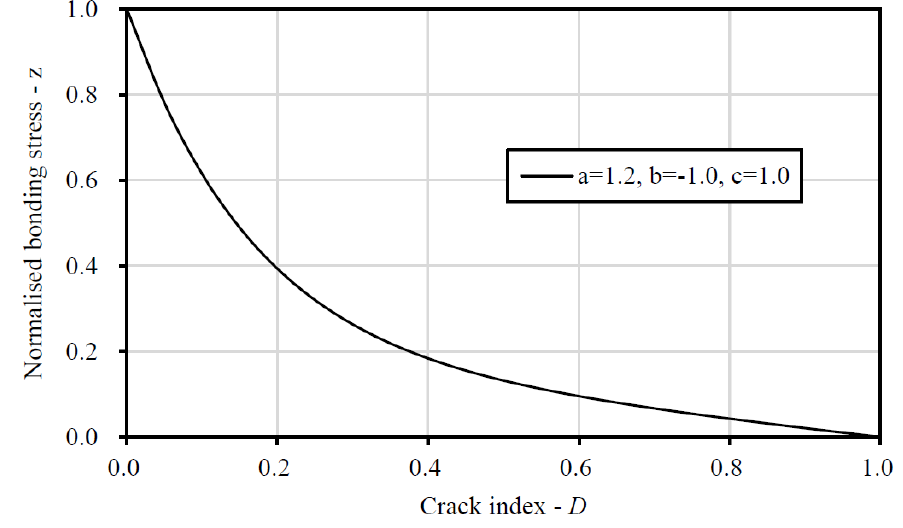
Figure 3. The normalised strain softening curve of glass.